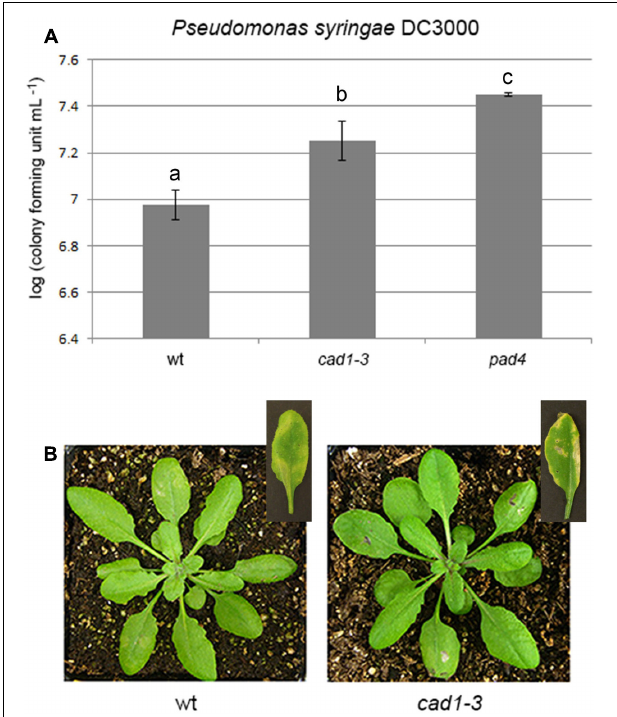
FIGURE 4 | Bacterial growth (A) and induced disease symptoms (B) of Pseudomonas syringae DC3000 infiltrated for 48 h, at a concentration of 3 · 10 5 bacterial colony forming units mL – 1 , in leaves of 28-day-old wt, cad1-3 , or pad4 plants. In the insets of (B) , representative leaves 7 days after the bacterial infiltration are shown. n = 12, error bars indicate SE. Statistical analysis was performed by one-way ANOVA followed by the Bonferroni’s post hoc test. Different letters indicate statistically significant differences at p ≤